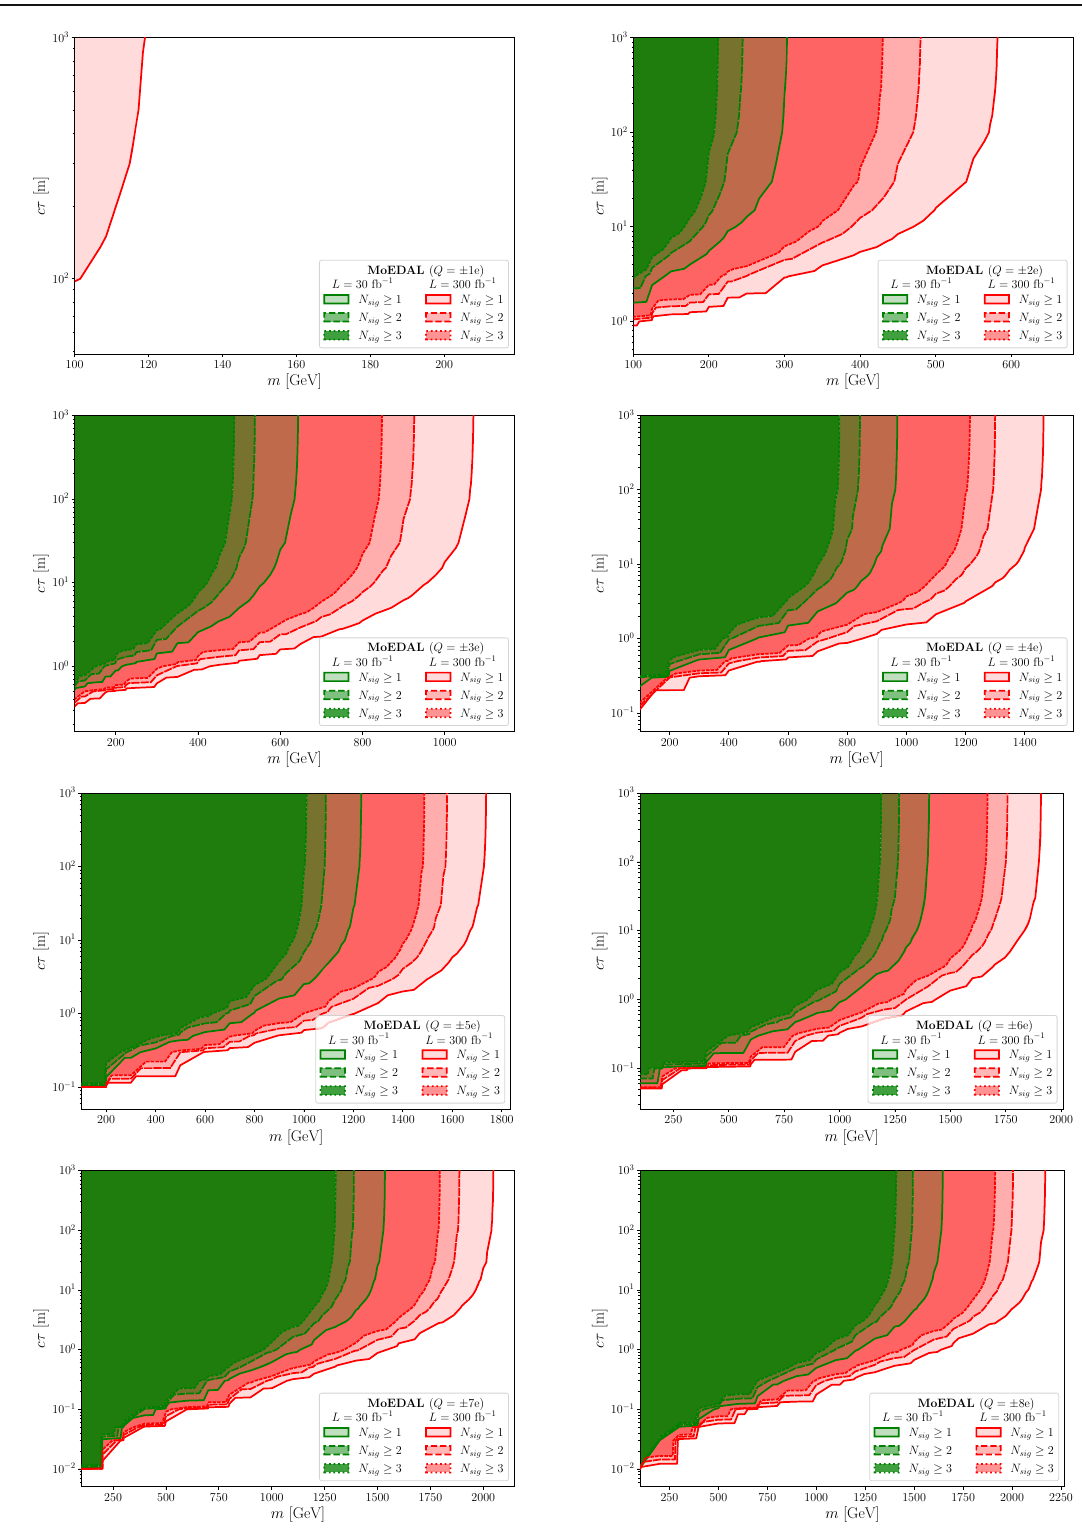
Fig. 15 Model-independent detection reach at MoEDAL in the ( m , c τ ) parameter plane for colourless scalars. The solid dashed and dotted contours correspondto N sig = 1,2and3,respectively.GreenandredcontourscorrespondtoRun-3 ( L = 30 fb − 1 ) andHL-LHC ( L = 300 fb − 1 ) luminosities